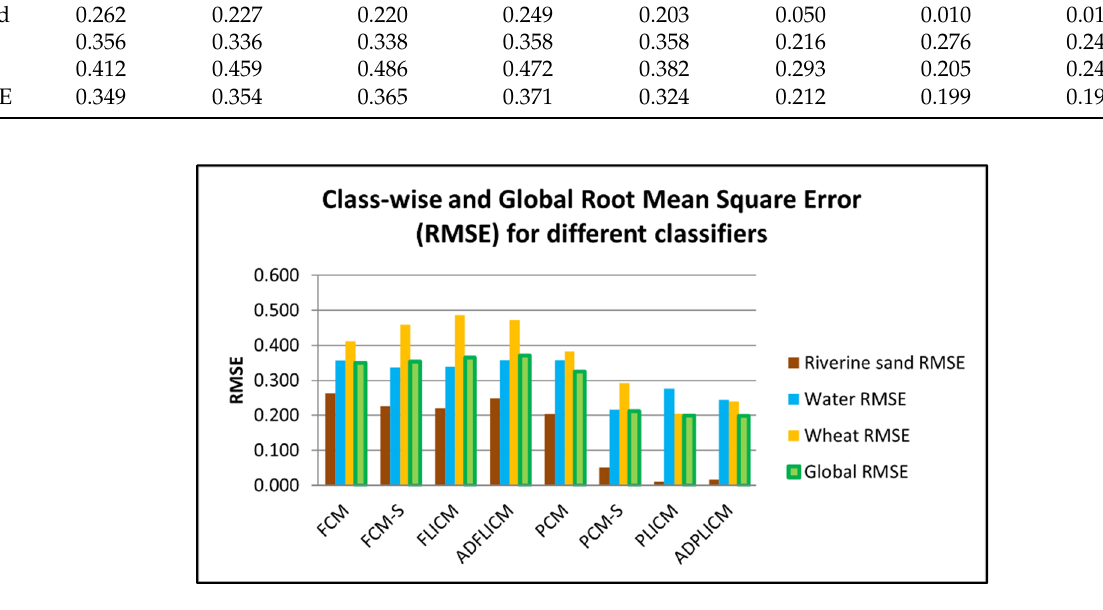
Figure 17. Accuracy assessment results of the classifiers based on RMSE values.